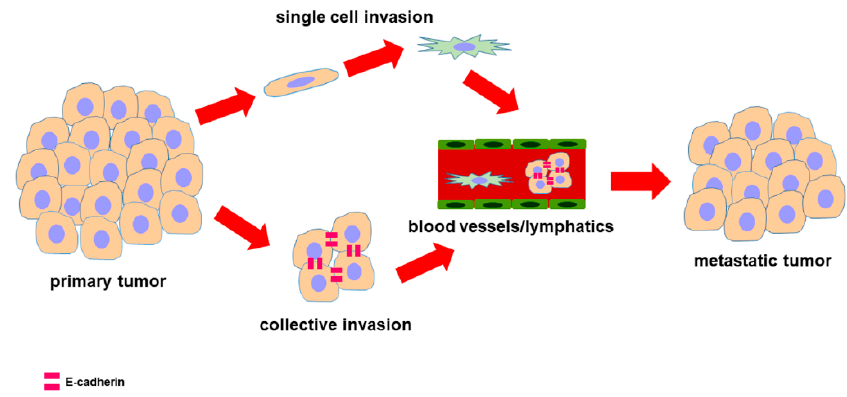
Figure 4. Diagram showing the possible strategies used by carcinoma cells for migration and invasion. Carcinoma cells, having a differentiated epithelial phenotype, retain E-cadherin at the cell membrane providing a strong cohesion during collective migration and invasion. By contrast, single cell invasion is played by cells that, after losing their epithelial features during EMT, switched to a mesenchymal phenotype. Once arrived at metastatic niche, these cells reacquired epithelial characteristics through another process defined mesenchymal to epithelial transition (MET). The third and last consideration is referred to the in vivo evaluation of E-cadherin in human PDAC specimens. When analyzing PDAC cells in vitro, the detection of EMT markers and their relationship in determining cell phenotype can be easily deciphered than in tumor samples. In tumor tissues, E-cadherin is frequently retained and its loss undetectable, so that there is no clear demonstration of EMT in human tumor biopsies. In relation to this issue, we have to consider that most human tumors are characterized by cellular heterogeneity, so that a clear phenotype does not prevail. Moreover, even if E-cadherin is retained, we cannot exclude that cells underwent EMT, since this process might be highly localized and transient, and possibly functions as a brief proinvasion conversion program limited to specific steps and timing in metastatic colonization. Since E-cadherin is the major determinant of the epithelial phenotype and the main actor of the EMT process, the characterization of E-cadherin multifaceted expression allows the interpretation of different roles during the steps of EMT (Figure 5). Only the deciphering of its expression in relation to the cell phenotype and the timing of its loss during the transition of normal ductal epithelium to invasive cancer will allow to better understand PDAC biology and behavior, in order to develop new and effective therapeutic tools.